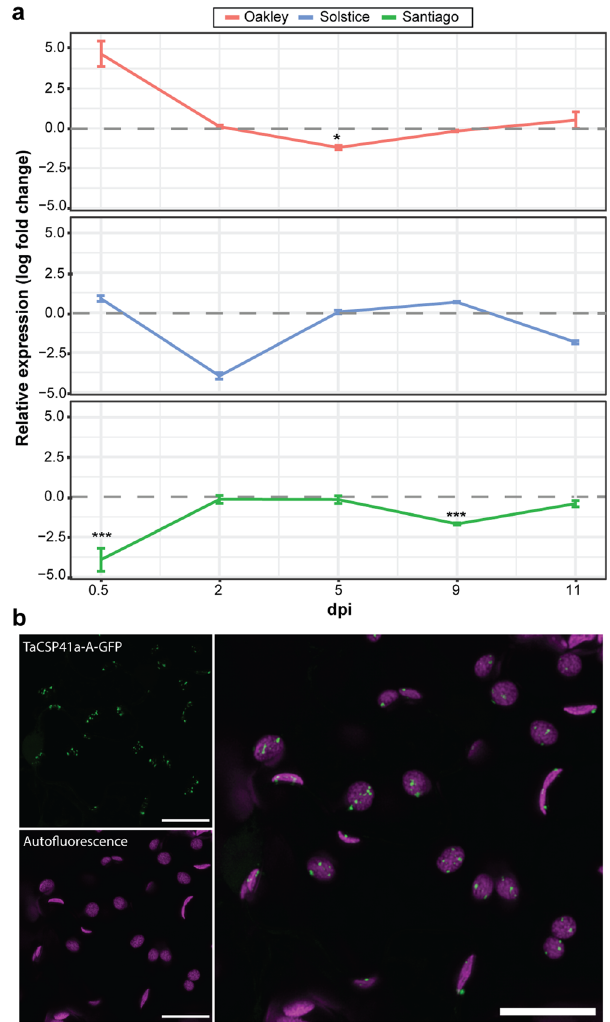
Fig. 6 TaCSP41a encodes a putative chloroplast-localised protein and its expression early during Pst infection is linked to host susceptibility. a TaCSP41a expression during a controlled infection time course of the wheat varieties Oakley, Solstice and Santiago with Pst isolate F22. Relative TaCSP41a expression was measured by RT-qPCR from all three homoeologous copies simultaneously and compared to mock-inoculated control plants, with the UBC4 gene used as a reference 53 . Two independent leaves from the same plant were pooled and three independent plants were analysed for TaCSP41a expression at each time point. Asterisks denote statistically signi fi cant differences (*** p < 0.005, ** p < 0.01, * p < 0.05; 2-tailed t -test). b TaCSP41a-A co-localises with chlorophyll auto fl uorescence. TaCSP41a-A-GFP was transiently expressed in N. benthamiana and images were captured after 2 days. Images are representative of >10 images captured, all displaying co-localisation of TaCSP41a-A-GFP and chlorophyll auto fl uorescence. Left, individual TaCSP41a-A-GFP (top) and chlorophyll auto fl uorescence (bottom) patterns; right, merged image of TaCSP41a-A-GFP and chlorophyll auto fl uorescence illustrating co-localisation. Scale bars, 10 μ